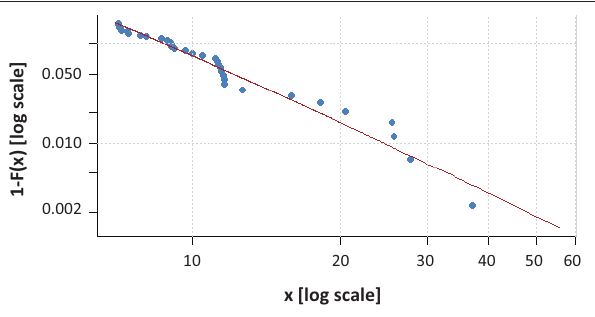
FIGURE 10: South Africa – Diagnostic plot for peak over threshold analysis: QQ- plot of the residuals.